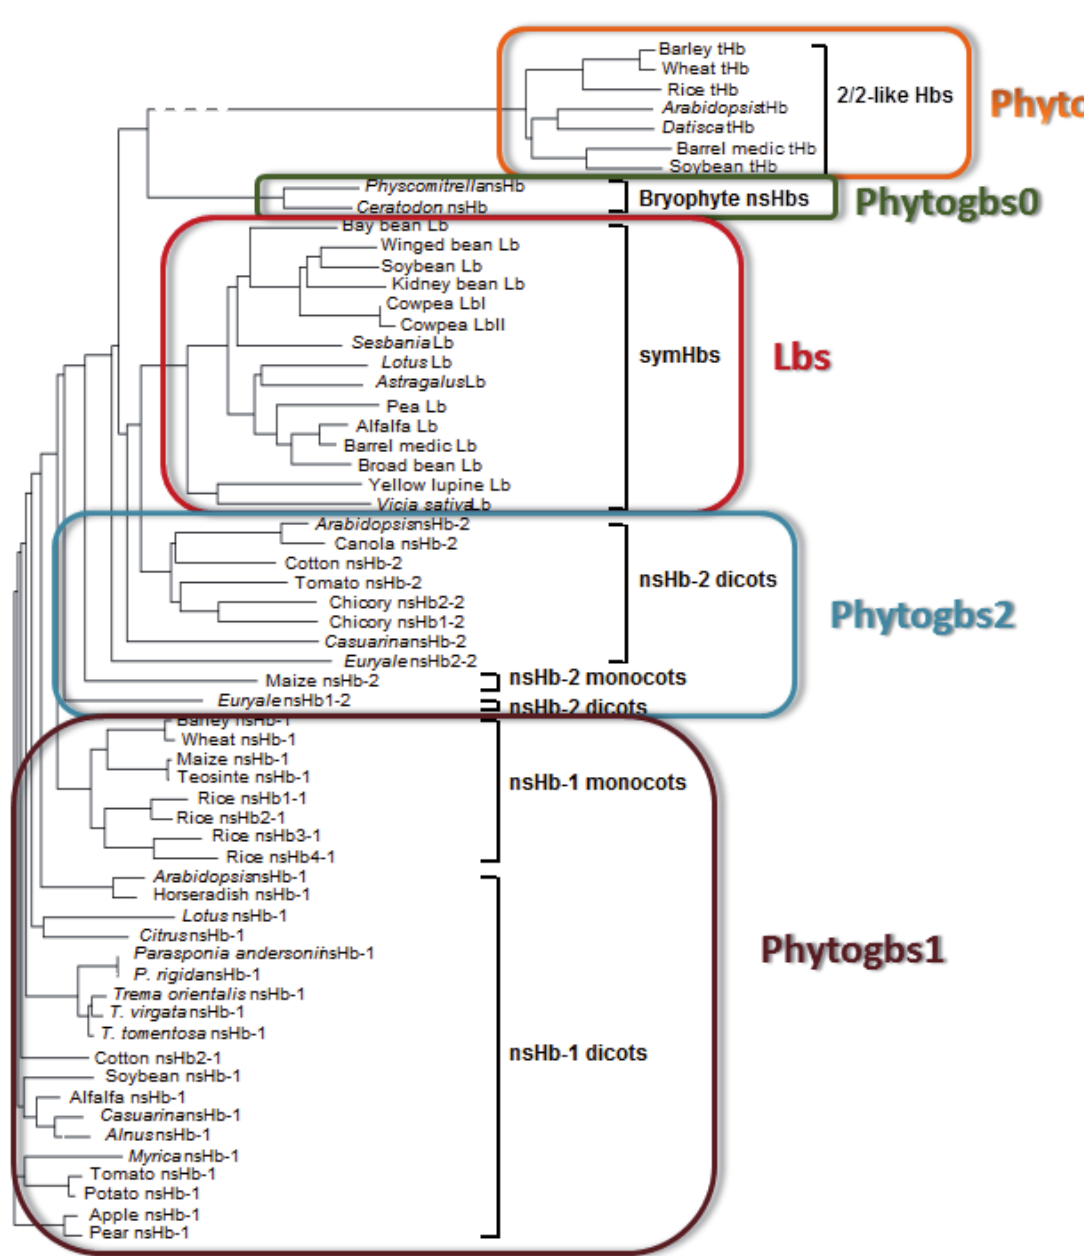
Figure 1. Phylogenetic representation of the novel nomenclature for land plant Phytogbs. Note that Parasponia , Casuarina , Alnus and Myrica SymPhytogbs are intermediate between SymPhytogbs and Phytogbs1 and Phytogbs2 (see Table 1 for explanation). Figure modified from Garrocho-Villegas et al. 23 (reprinted with